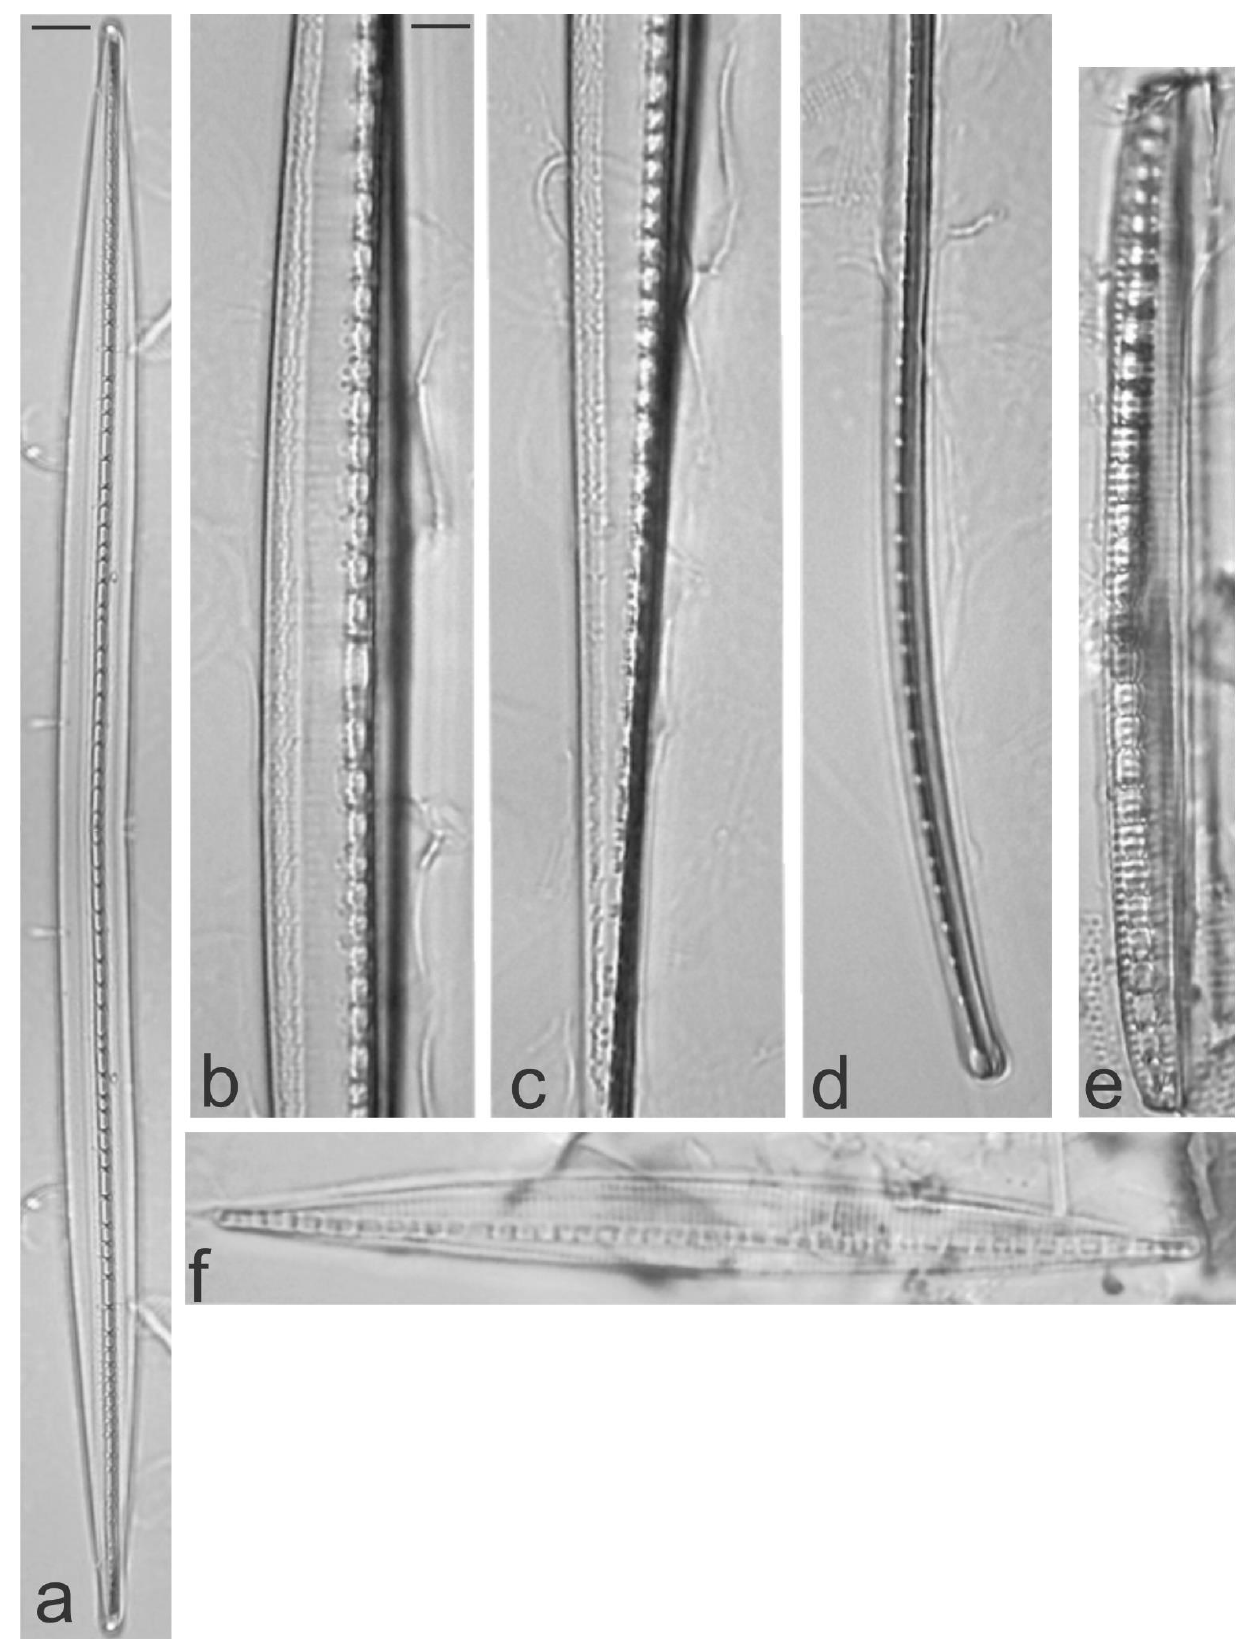
Figure 32. ( a ) Nitzschia distans ; ( b – d ) N. behrei ; ( e ) N . insignis ; ( f ) Bacillaria socialis . Scale bar = 5 μm.